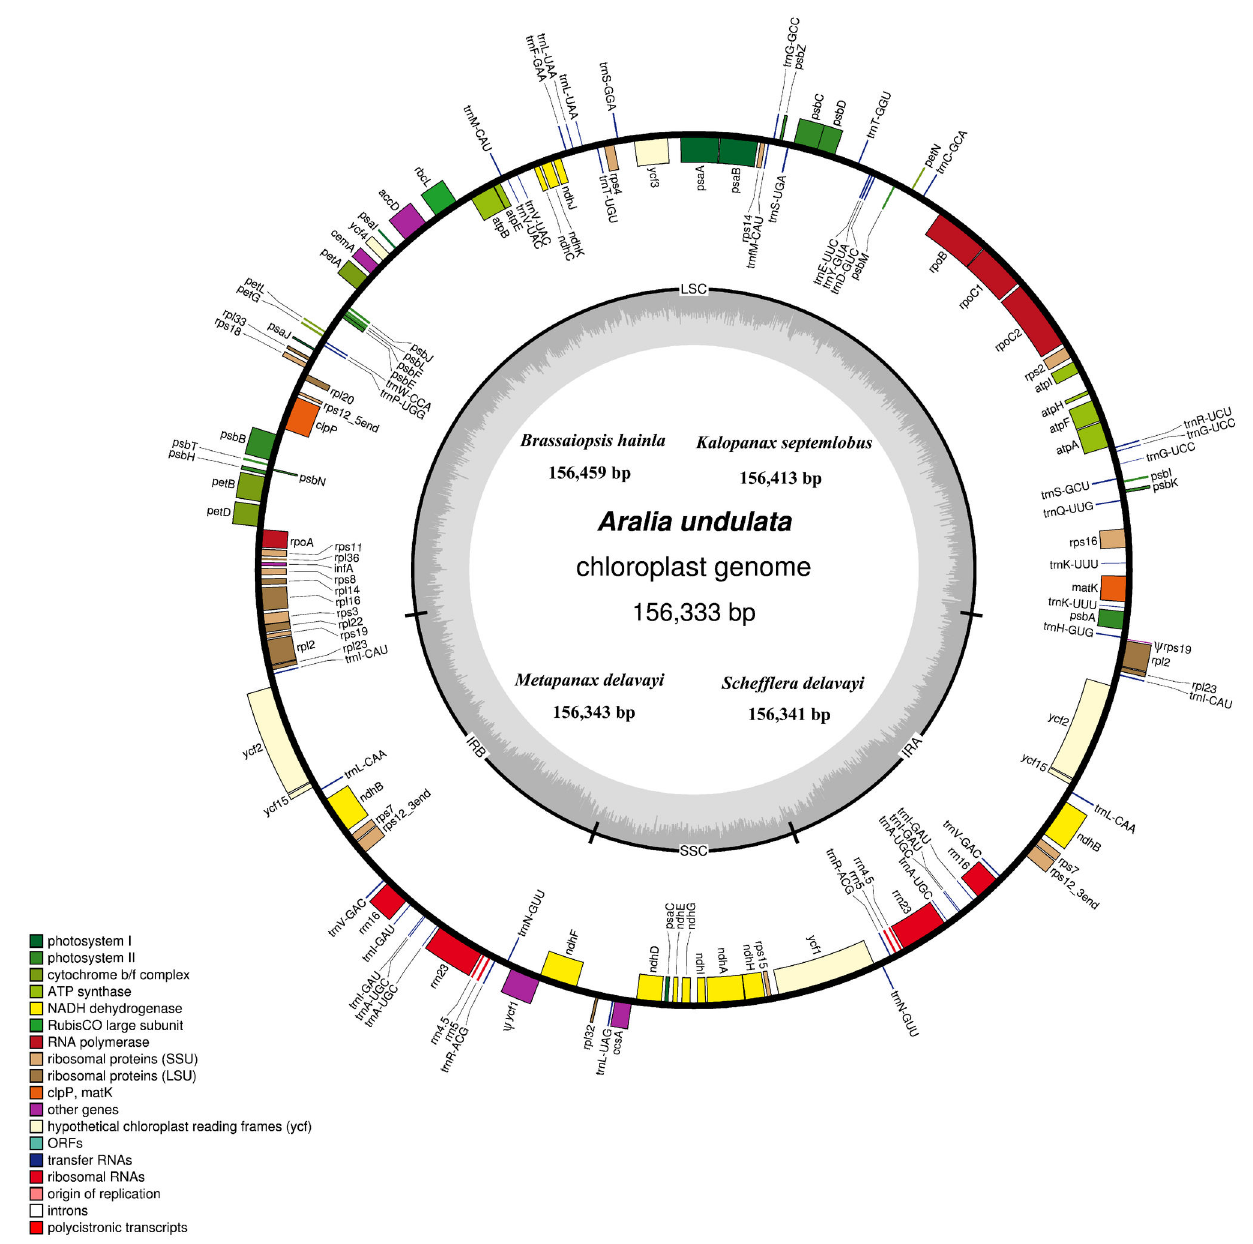
Figure 1. Gene map of the five Araliaceae chloroplast genomes. Genes on the outside of the outer circle are transcribed in the clockwise direction and genes on the inside of the outer circle are transcribed in the counterclockwise direction. Functional categories of genes are color-coded. Dashed area in the inner circle indicates the GC content of the chloroplast genome.